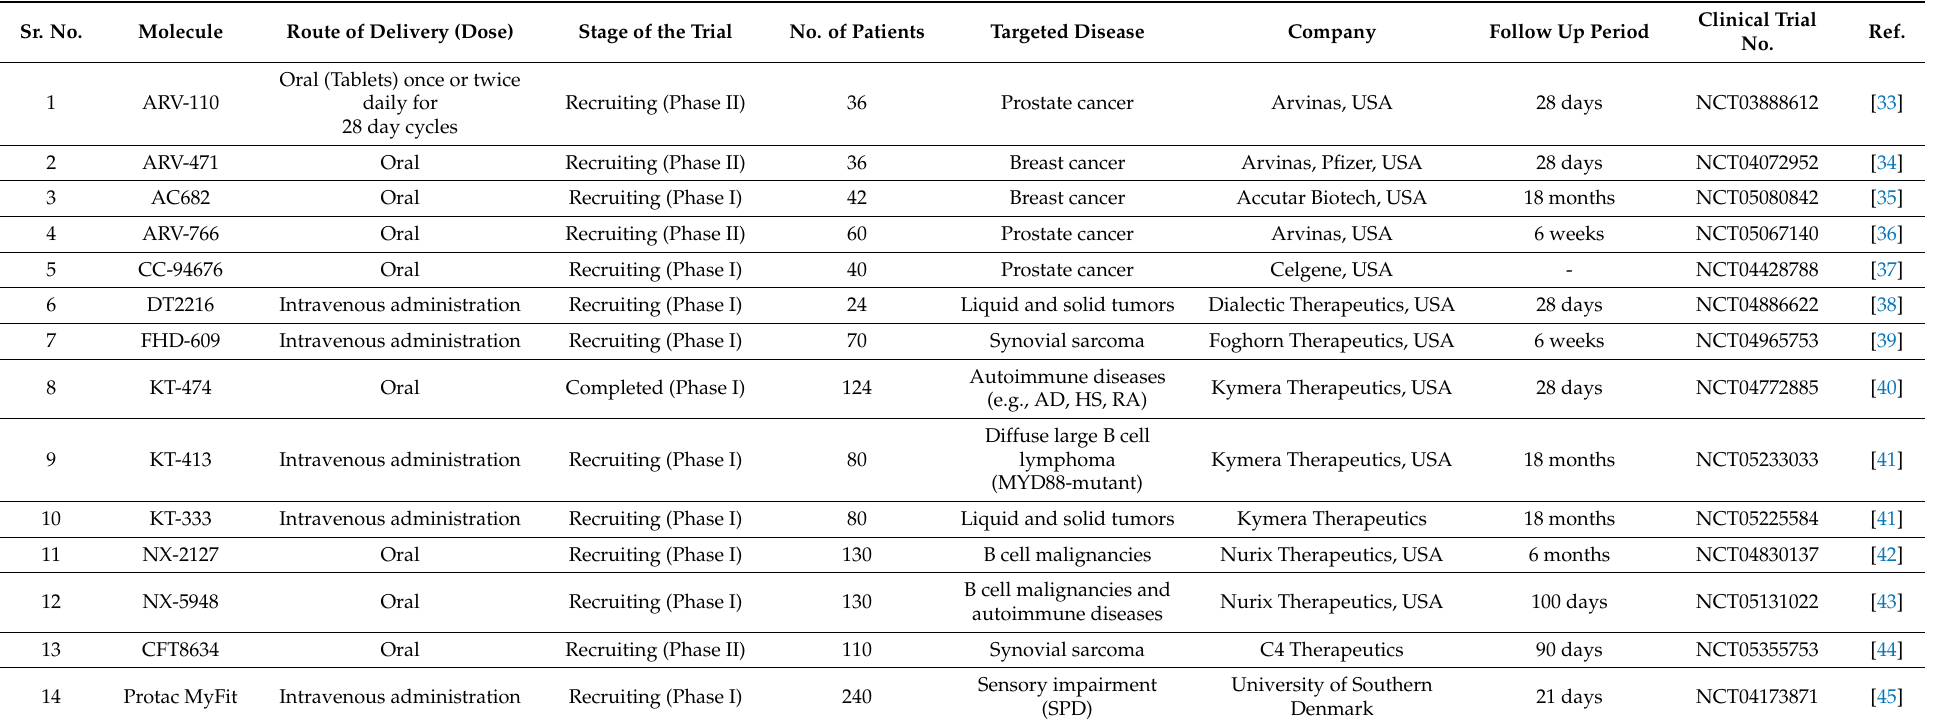
Table 1. Comprehensive representation of clinical cases of